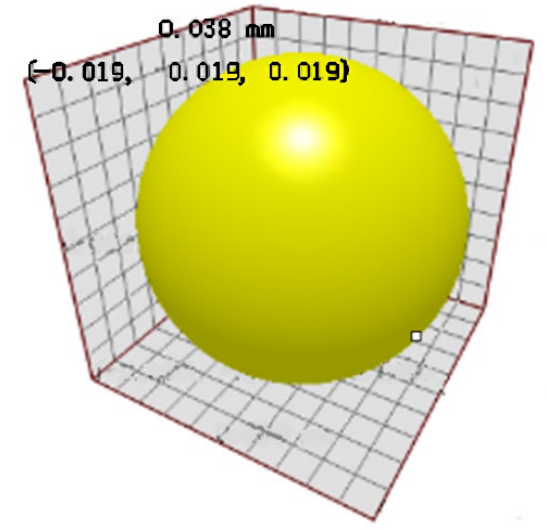
Figure 6. Microscopic morphology of powder particles.